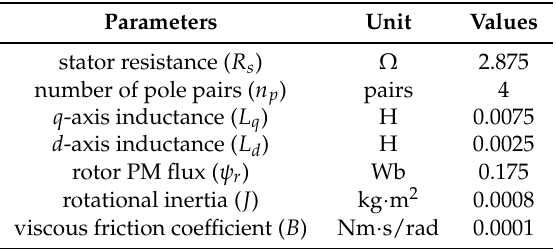
Table 1. Parameters of the permanent magnet synchronous motor.